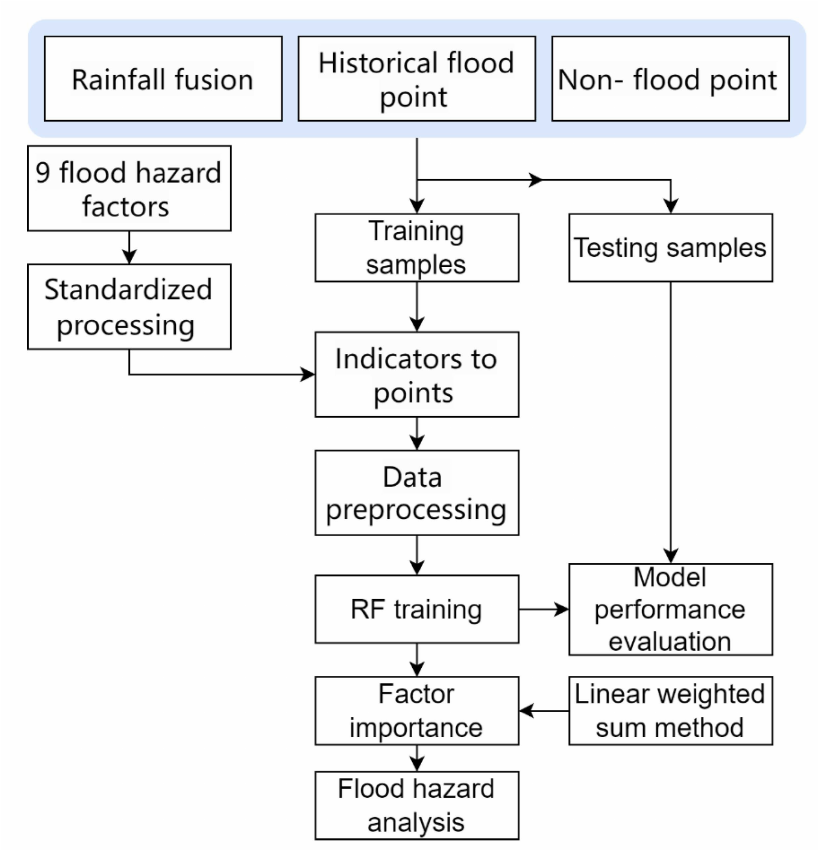
Figure 3. Schematic diagram of flood hazard analysis